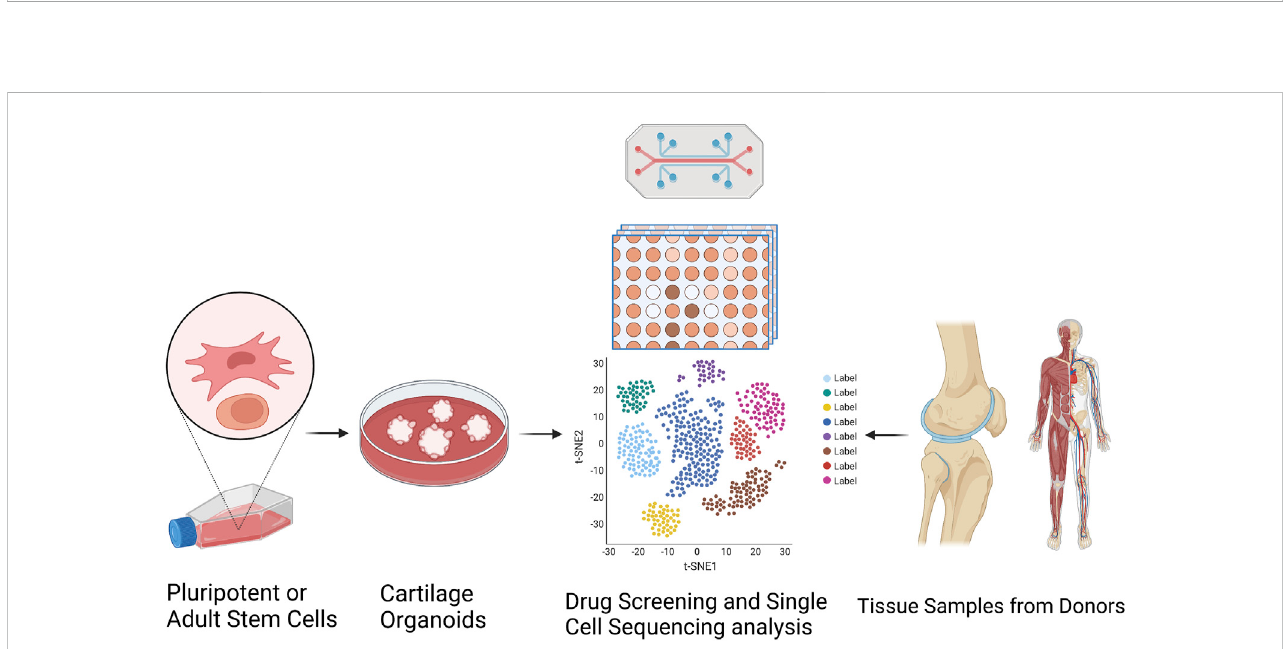
FIGURE 4 Establishment of cartilage organoid cell atlas through RNA sequencing-based drug discovery and single cell multi-omics analysis. Targeted organoid sequencing through a high-throughput, high-content drug discovery platform targeting RNA-seq to monitor the expression of large gene signatures for the detailed evaluation of cellular phenotypes in cartilage organoids generated from pluripotent or adult stem